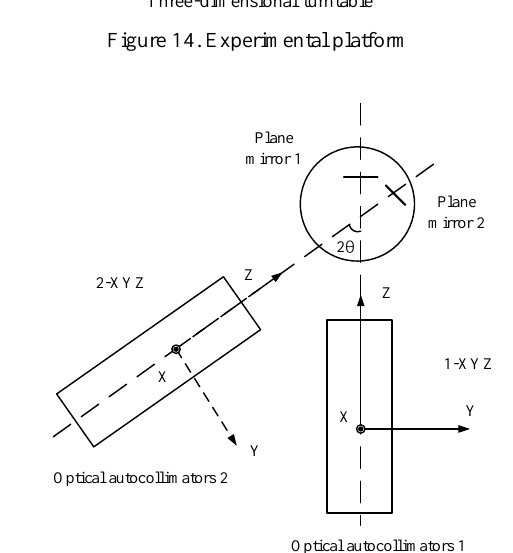
Figure 15. Coordinate system